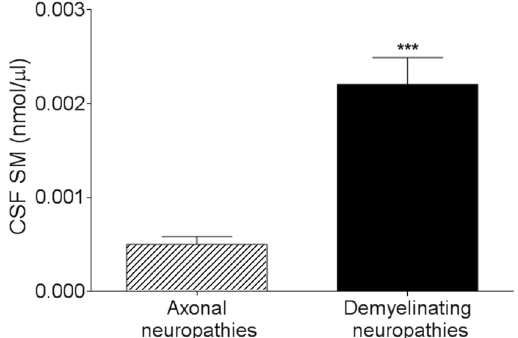
Figure 3. SM is able to distinguish axonal from demyelinating neuropathies. SM alone was significantly increased in patients affected by demyelinating neuropathies (n = 14) compared to those affected by axonal